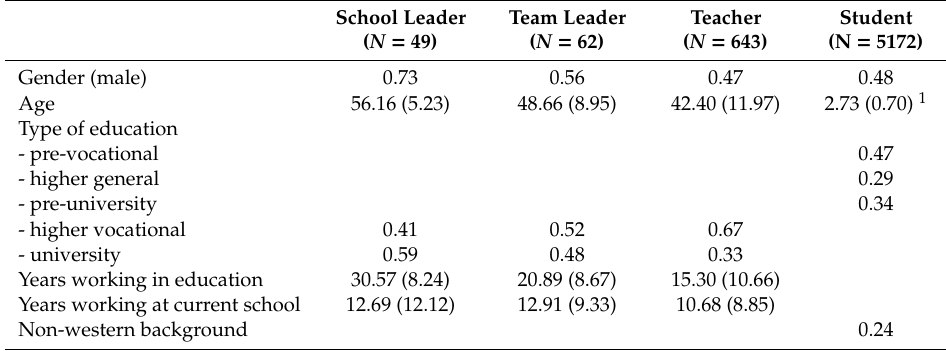
Table A1. Demographics of respondent